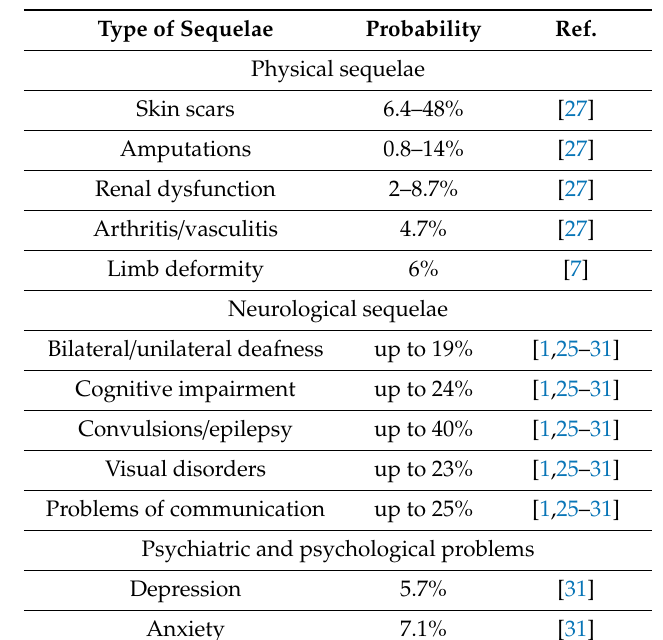
Table 1. The most frequent types of sequelae (physical, neurological and / or psychological), reported in the